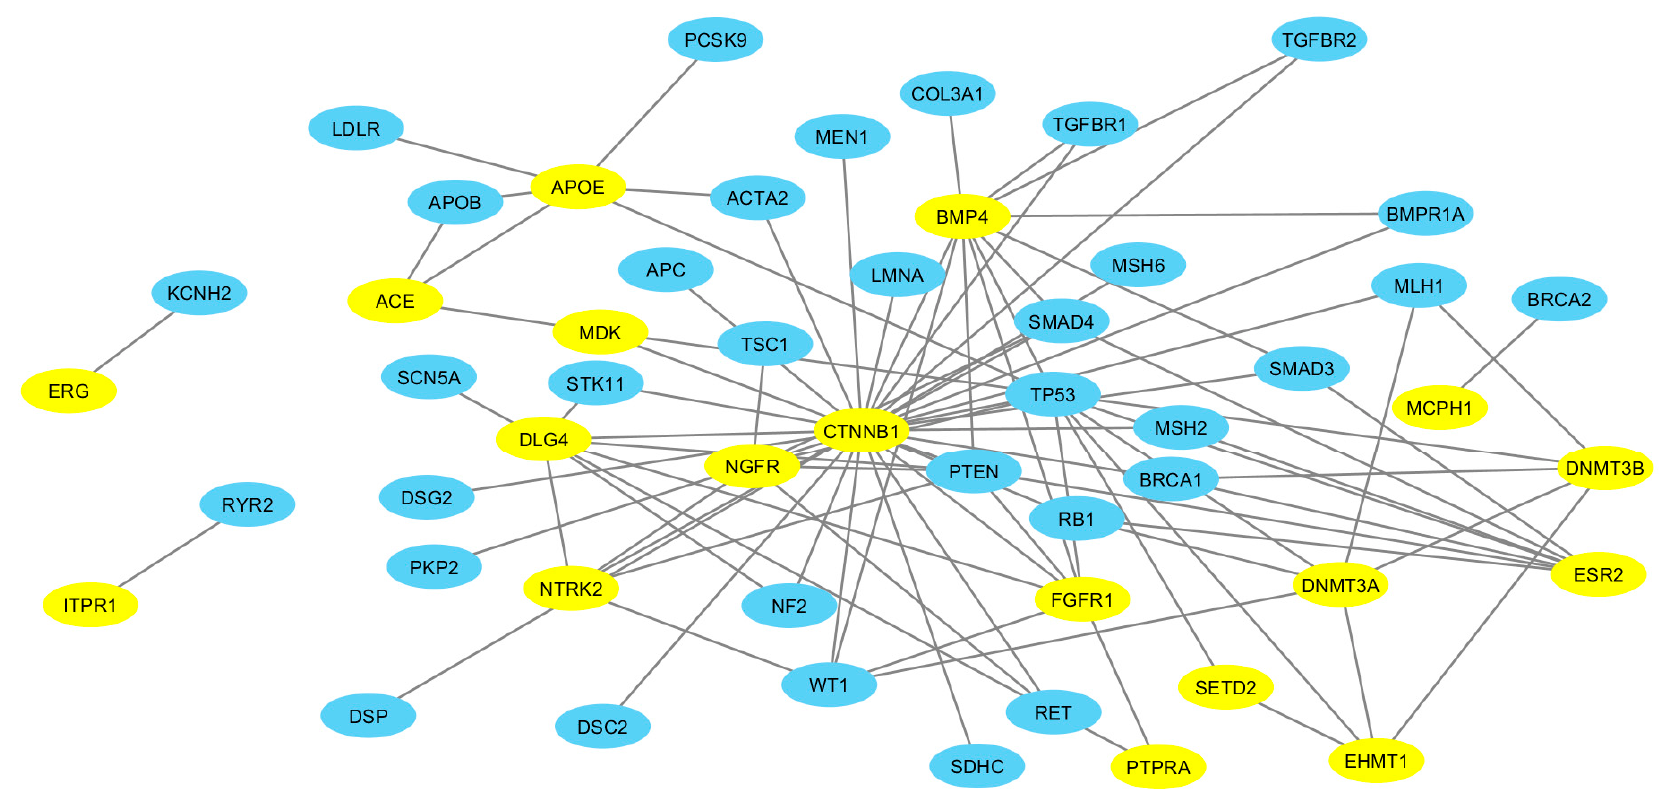
Figure 3. Prioritized ASD Proteins and ACMG Proteins Interaction Network. Shown are direct interactions predicted between proteins encoded by ASD candidate genes annotated in all pipeline categories and proteins encoded by American College of Medical Genetics (ACMG) recommended actionable genes. Top ASD-related proteins are highlighted in yellow, ACMG-recommended proteins in blue. Notably, none of the prioritized ASD genes were represented among the 59 genes compiled by the ACMG.